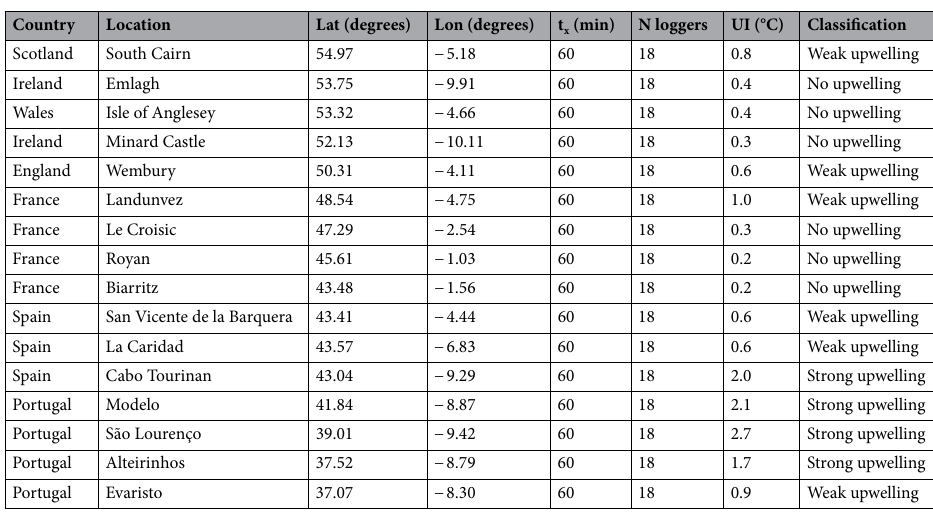
Table 1. Coastal locations of (in situ) water temperature measurements used in this study. The sites were selected to represent the broad range of Patella vulgata’s southern distribution. Temperatures were recorded by Maxim DS1922 iButton loggers deployed in the intertidal at 0–1 m below Mean Sea Level (MSL) at a particular frequency (in minutes, t x ). Daily values were obtained by averaging data collected by one of multiple sensors (N loggers). These in situ measurements were used to calculate a Thermal Upwelling Index (UI, in °C) for each location, defined as the magnitude of the cold anomaly (i.e. cold bias) between upwelled coastal waters and the warmer offshore waters 47,66 . Manufacturer reported logger accuracy and resolution for the iButton loggers were both 0.50